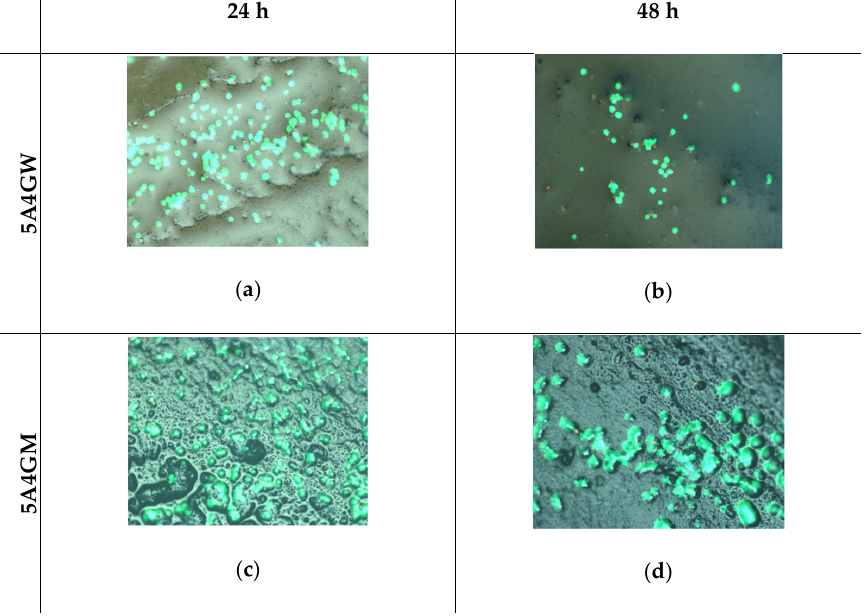
Figure 7. Endothelial cells (EA.hy 926 line) viability after direct contact with samples dissolved in water (W) and full culture medium (M) with different content of gelatine after 24 and 48 h of incubation.